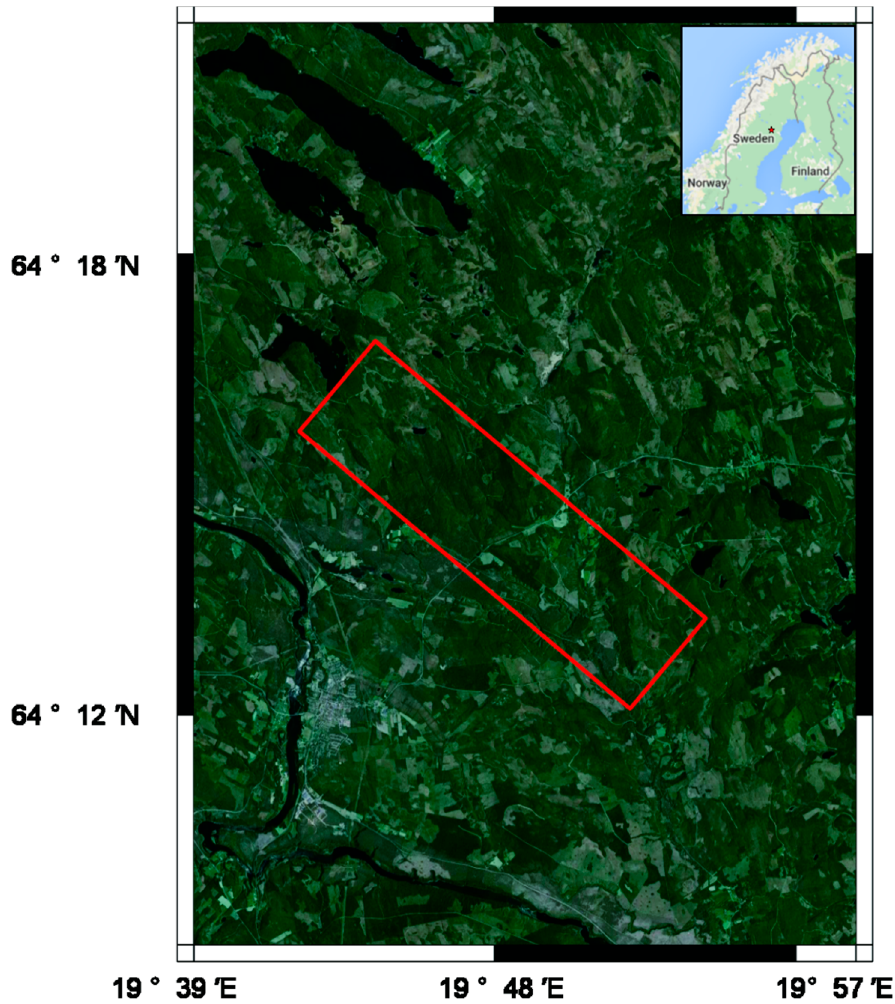
Figure 1. The test site selected from the BIOSAR 2008 campaign (From Google Earth). The star in the border map indicates the location of study area. The red rectangle indicates the covering area of the E-SAR data.